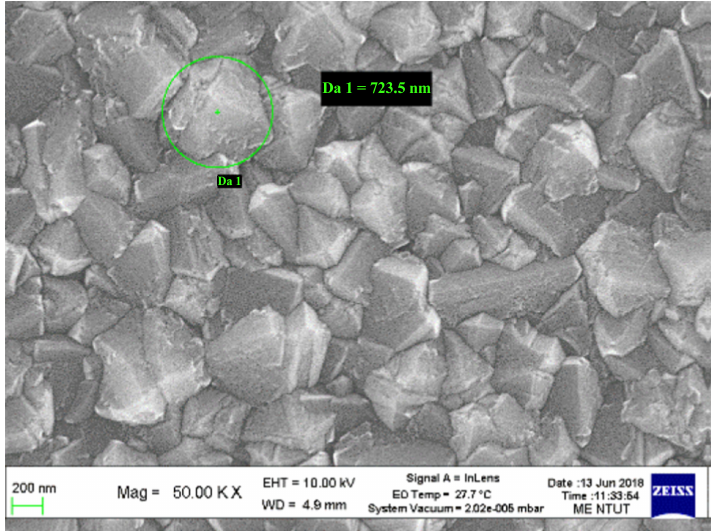
Figure 10. SEM image of the diamond film, exhibiting distributed particles with a size of ~1 μ m.